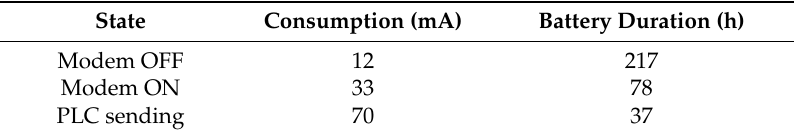
Table 3. Node consumption while not harvesting energy.